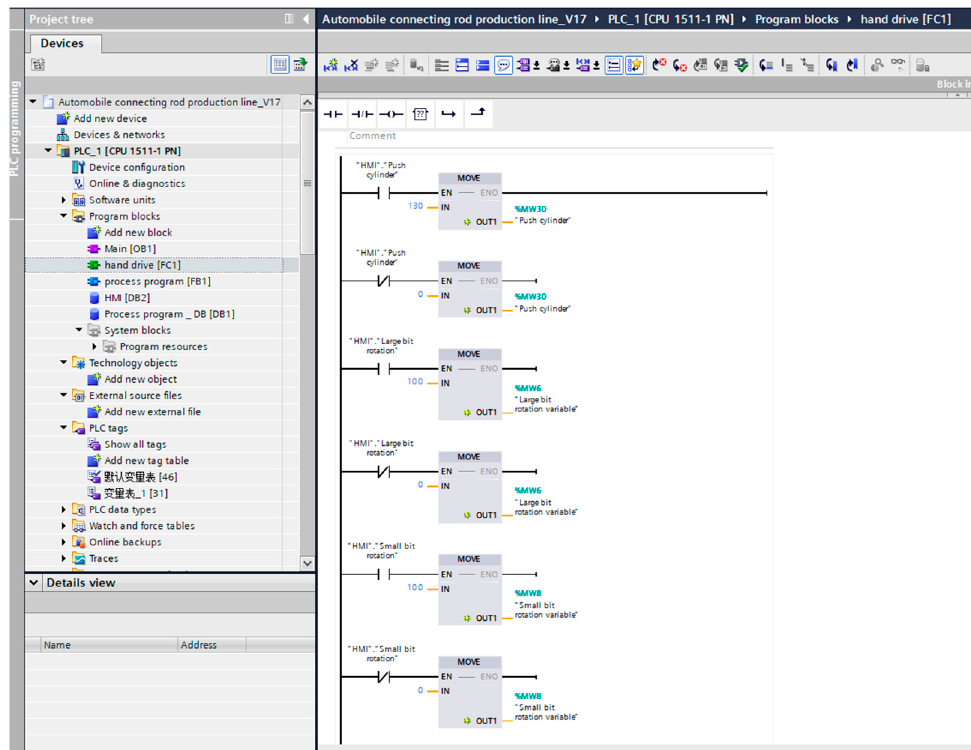
Figure 15. The manual processing mode control program.